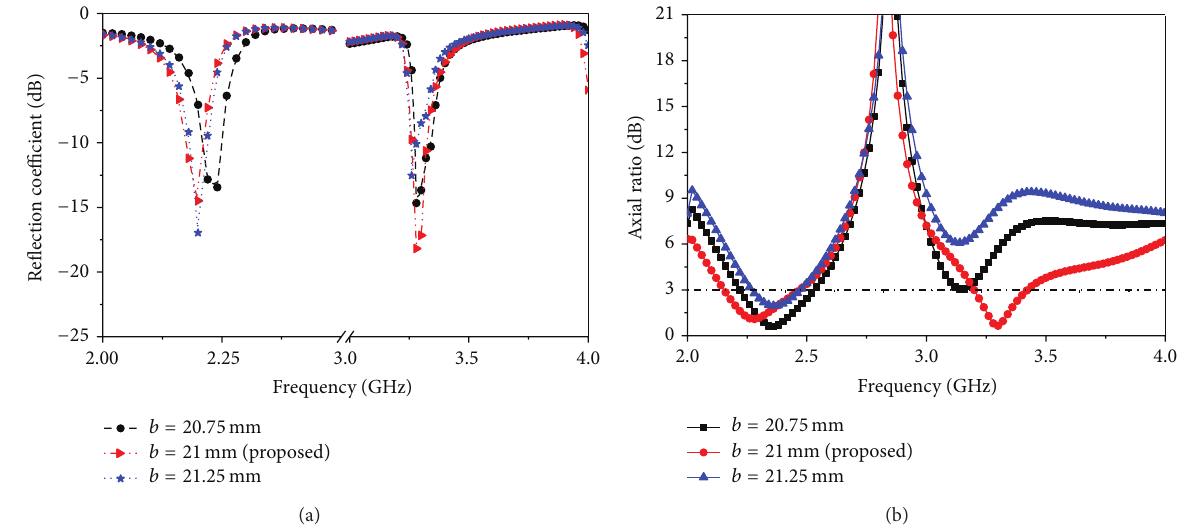
Figure 6: Different lengths of reflection coefficient and axial ratio results for the cross-shaped slot antenna. (a) Reflection coefficient and (b) axial